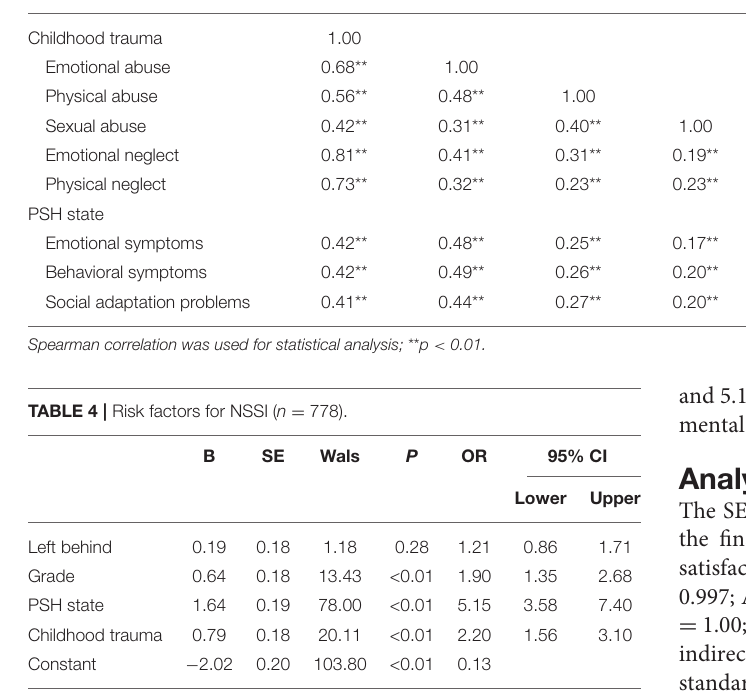
Table 3 presented the results of Spearman correlation